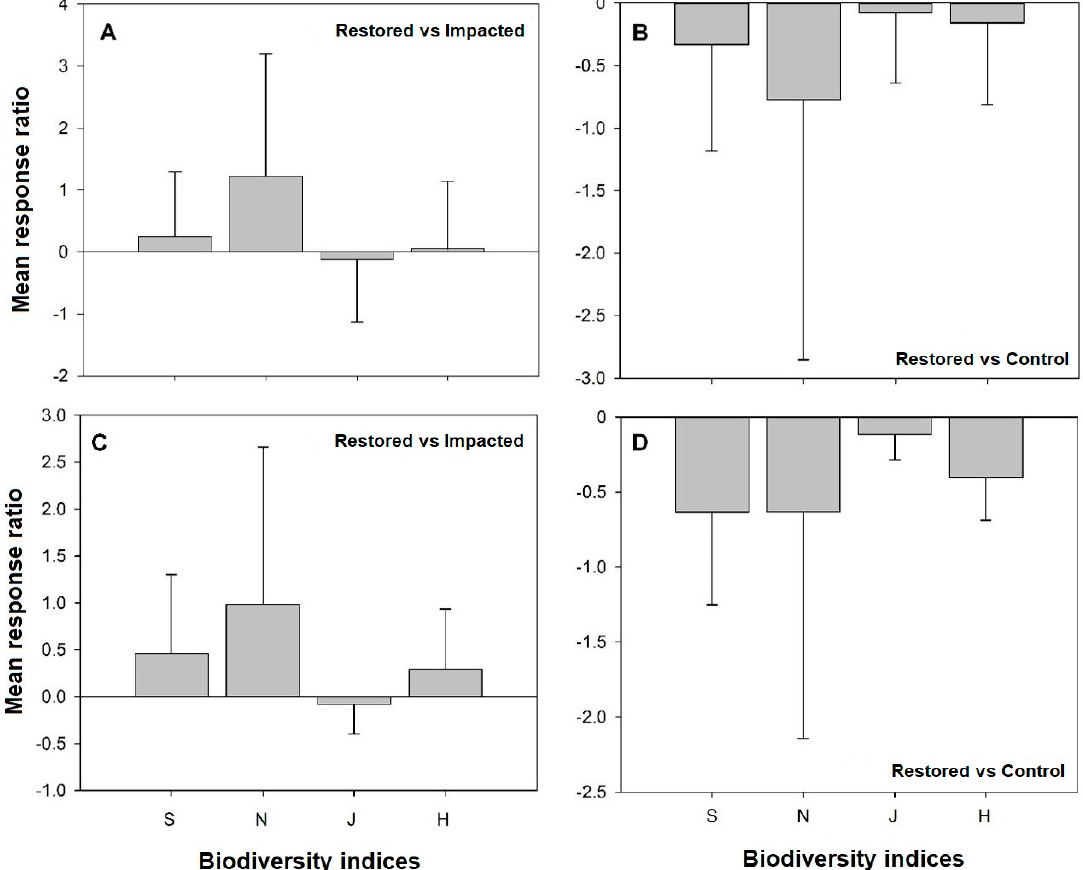
Figure 4. Mean ( ± standard deviation) biodiversity response ratios for epilithic algae from ( A ) restored vs. impacted and ( B ) restored vs. control, and for aquatic macroinvertebrates ( C ) restored vs. impacted and ( D ) restored vs. control. S: taxa richness, N: relative taxa abundance, J: Pielou’s evenness, and H: Shannon–Weaver diversity.